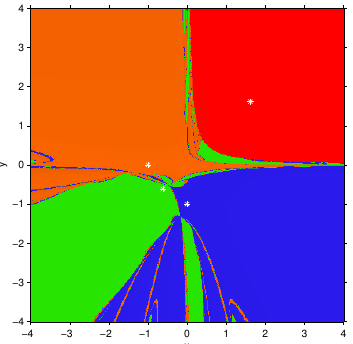
Figure 9. Dynamical plane of CMN m , RMN m and Newton’s method on p ( x ) . Green, orange, red and blue areas are the basins of attraction of the roots of q ( x ) (marked as white stars); black area denotes divergence and white squares are free critical